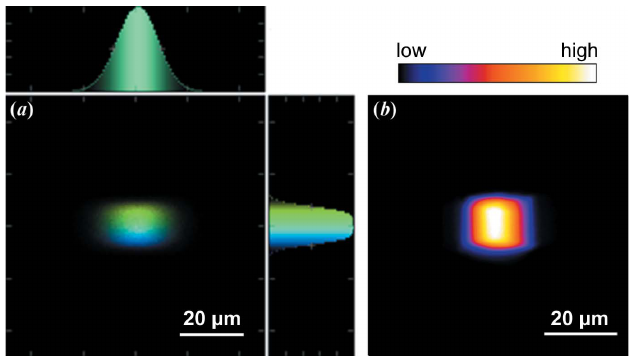
Figure 3 Beam profile at the sample position of the MAXPEEM beamline. ( a ) Simulation using X-ray tracing software (Klementiev & Chernikov, 2014), photon energy 40 eV; the energy slit is 150 m m (H) (cid:6) 150 m m (V). The color code is the energy dispersion that scales with the photon energy. It is (cid:7) 7 meV at 40 eV photon energy. ( b ) Experimental beam profile in the photoelectron microscope at 43 eV photon energy. The beamline energy slit is 150 m m (cid:6) 150 m m and the signal is from secondary photoelectrons discriminated by the energy analyzer of the microscope, with an energy window of 0.2 eV.